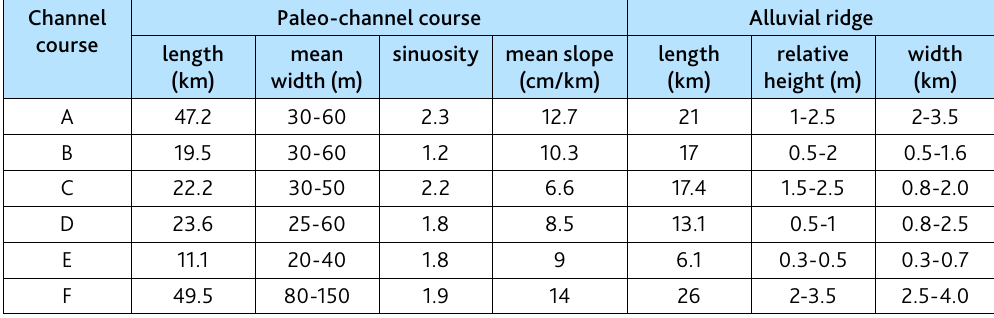
Table 1. Morphometric parameters of the paleo-channels and their alluvial ridges on the Bereg Plain Channel Paleo-channel course